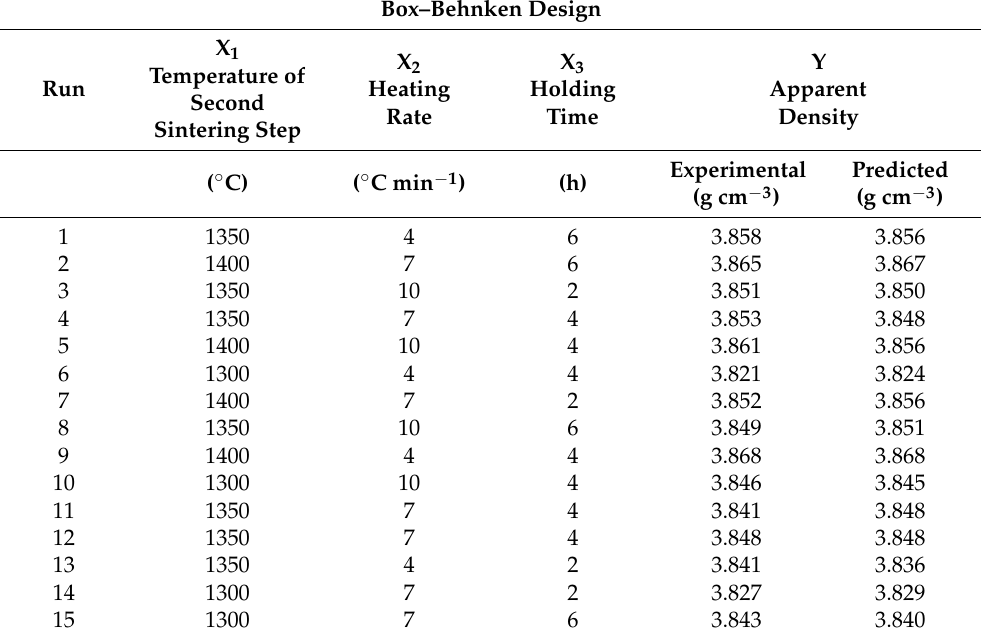
Table 3. Monitored responses and predicted data of applied BBD.